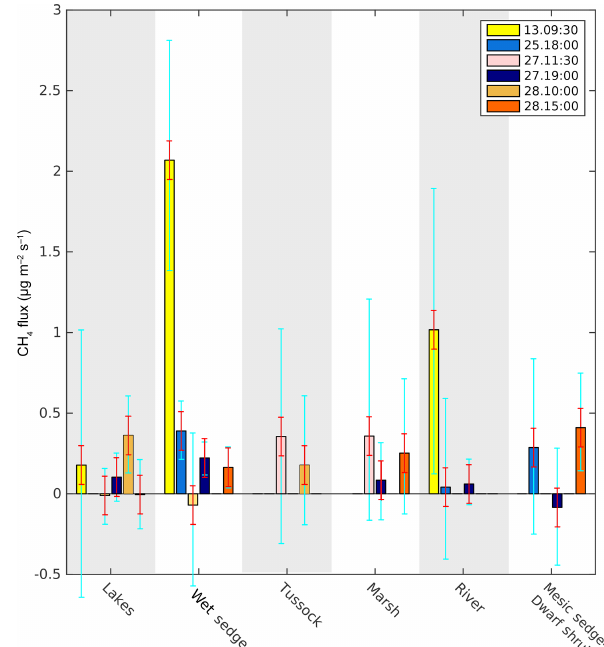
Figure 7. Mean methane fluxes by land surface class derived using the FFM for each of six flights as given in the legend. Dates of flights are given as day of month in August followed by the time of the middle of the flight. Bars give the instrument uncertainty (red) and the 95% confidence interval as calculated using bootstrapping